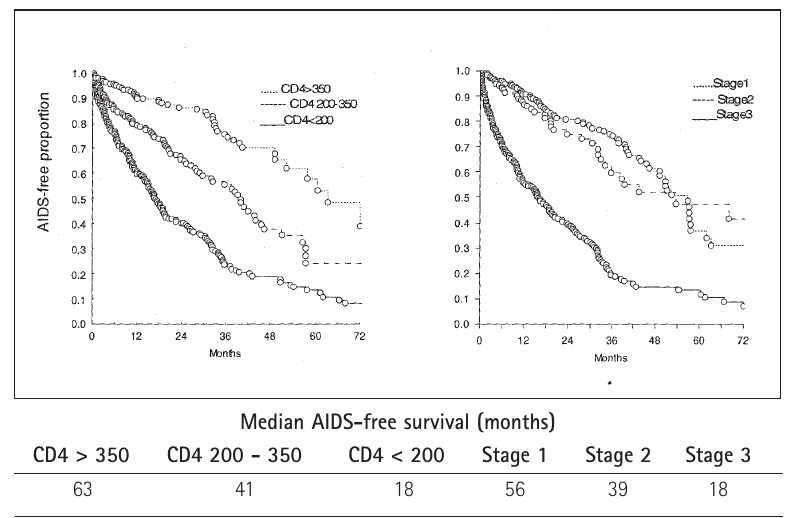
Fig. 1. Kaplan-Meier probabilities of AIDS-free survival according to baseline CD4